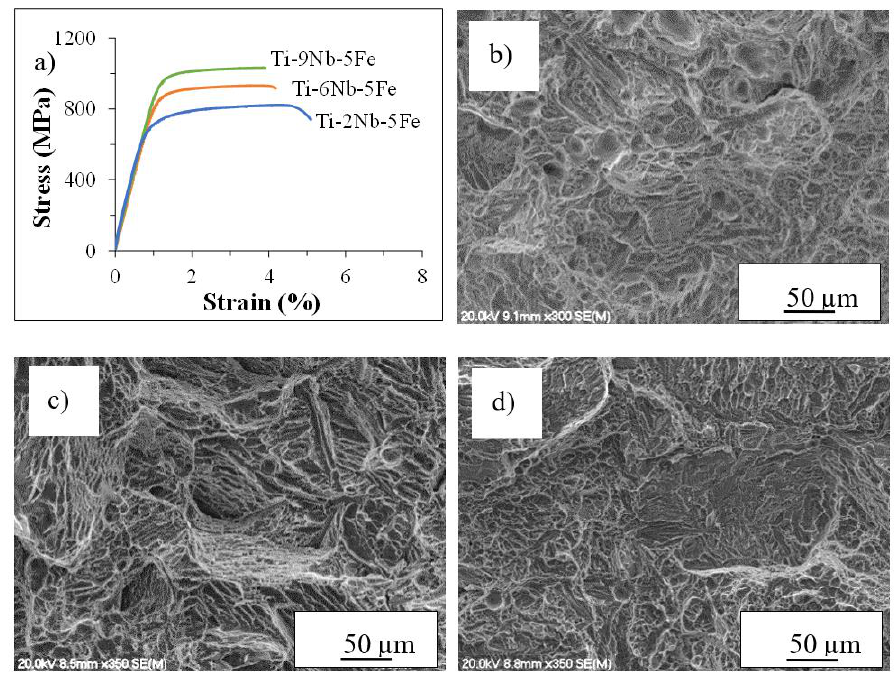
Figure 5. Representative tensile stress-strain curves ( a ) and micrographs ( b – d ) of the fracture surface of the Ti-5Fe-xNb alloys: ( b ) Ti-5Fe-2Nb, ( c ) Ti-5Fe-6Nb, and ( d ) Ti-5Fe-9Nb.